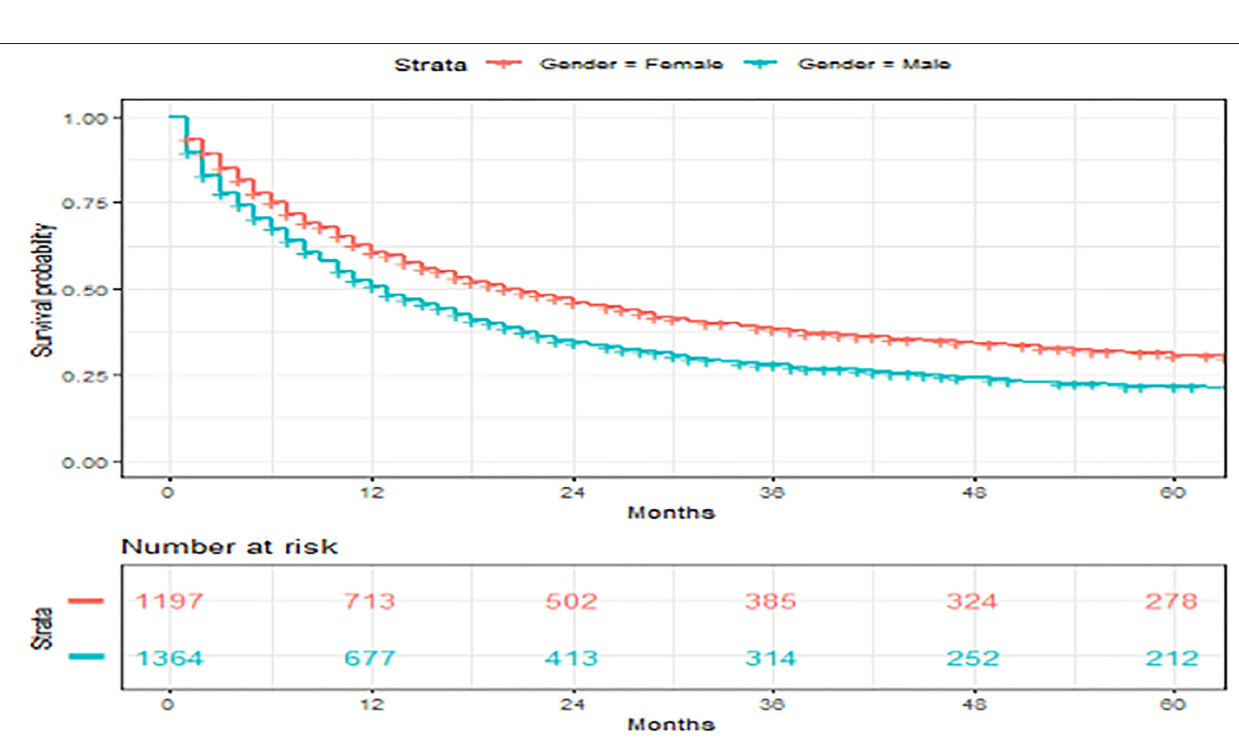
Frontiers in Surgery |